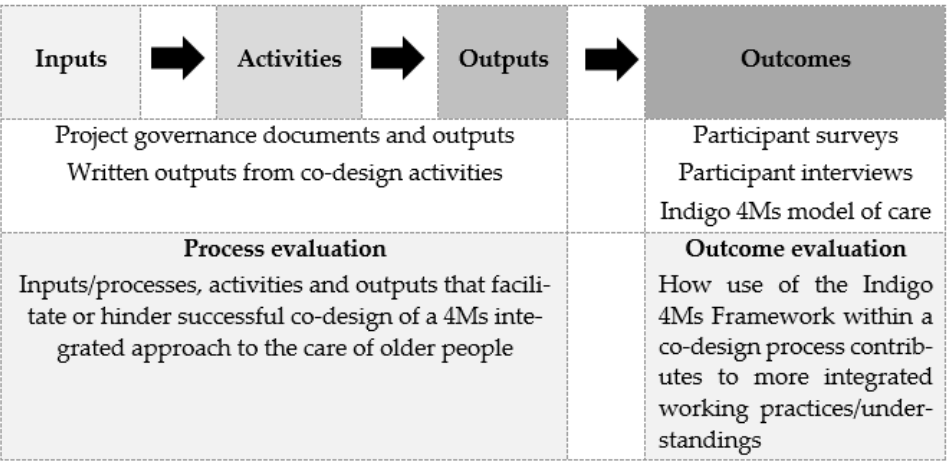
Figure 1. Program logic.